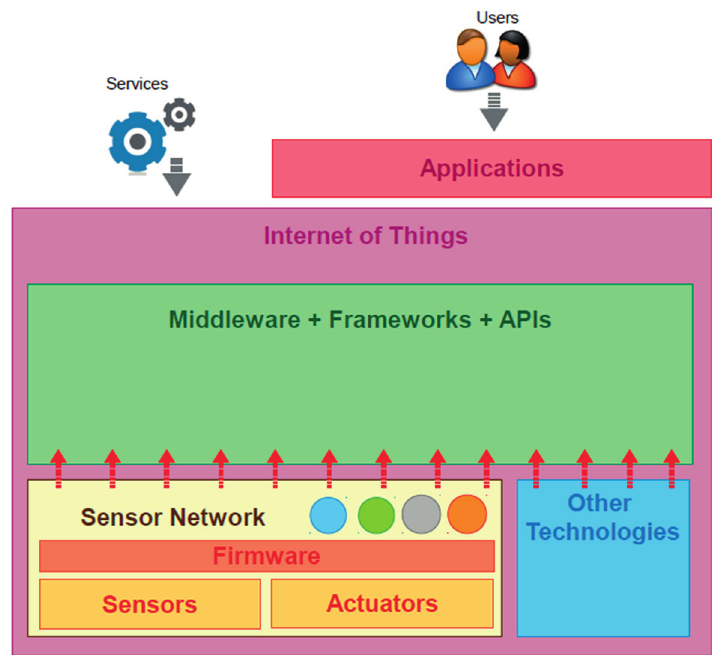
Figure 5. Relationship between sensor networks and IoT. Reproduced with permission from [15] Perera, C. et al. , IEEE Communications Surveys & Tutorials; published by IEEE,